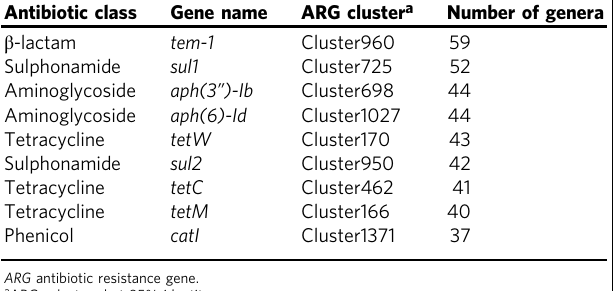
Table 1 Highly disseminated genes based on number of genera that contain them. Source data are provided in Supplementary Data 1 and